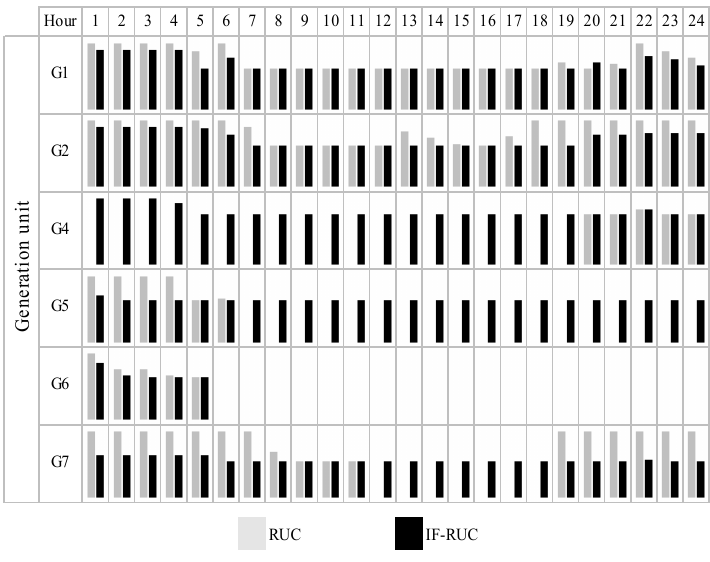
Figure 4. Changes in the operation of the conventional units.